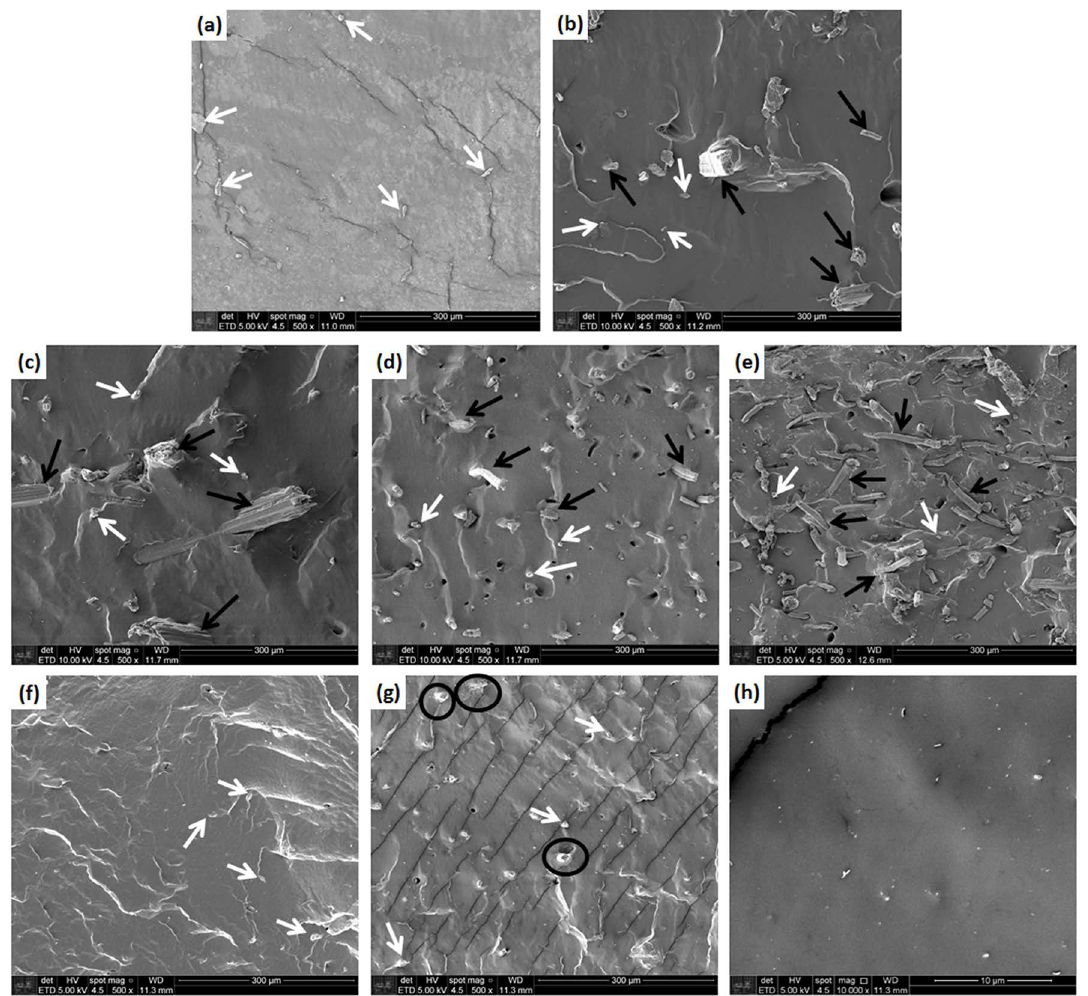
Figure 5. SEM images of (a) neat NR composite (×500); NR composites with (b) 5 phr of raw jute fibers (×500), (c) 10 phr of raw jute fibers (×500), (d) 5 phr of bleached jute fibers (×500), (e) 10 phr of bleached jute fibers (×500), (f) 5 phr of CNCs (×500), (g) 10 phr of CNCs (×500); and (h) composite with 5 phr of CNCs at higher magnification